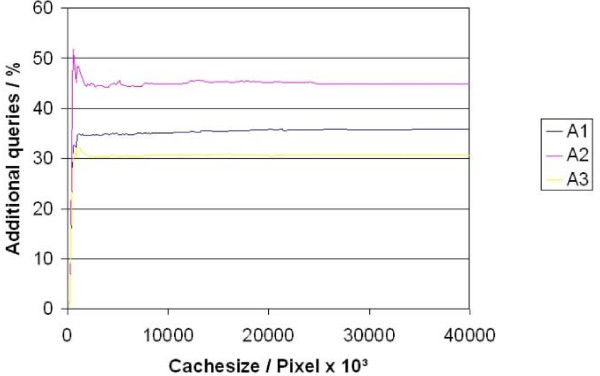
Additional queries.